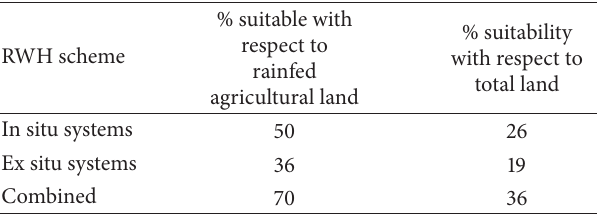
Table4:SuitabilityoftheUpperBlueNileBasinforwaterharvesting using a Boolean MCE